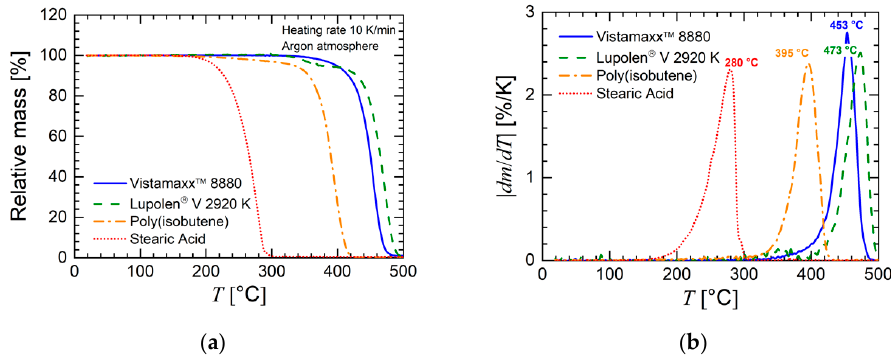
Figure 4. ( a ) Relative mass and ( b ) derivative of mass loss ( dm ⁄ dT ) as a function of temperature T